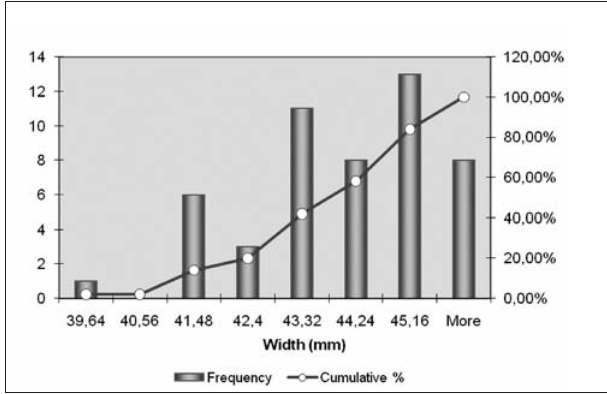
Fig. 27: Distribution of the width values of category A of Bergarouge